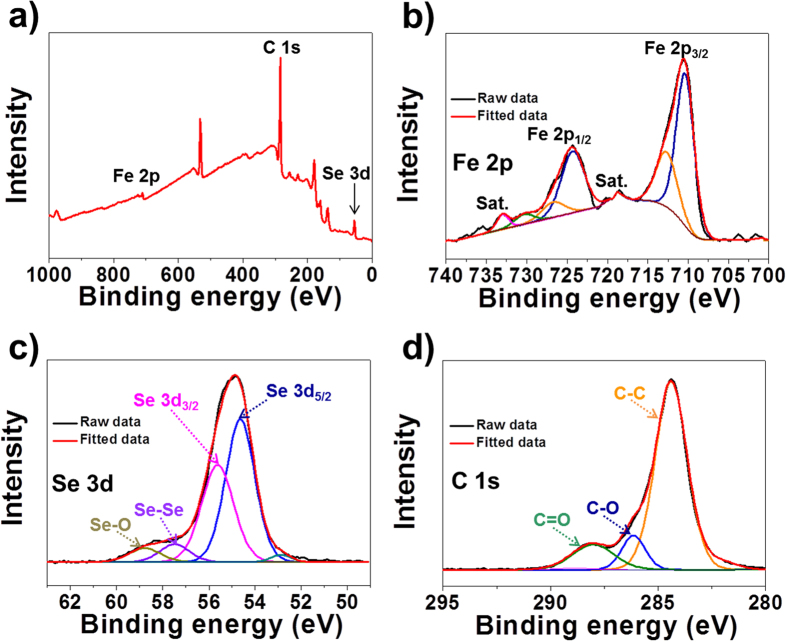
XPS spectra of the hollow FeSex-decorated rGO composite powders: (a) wide-scan XPS spectrum, (b) Fe 2p, (c) Se 3d, and (d) C 1 s.